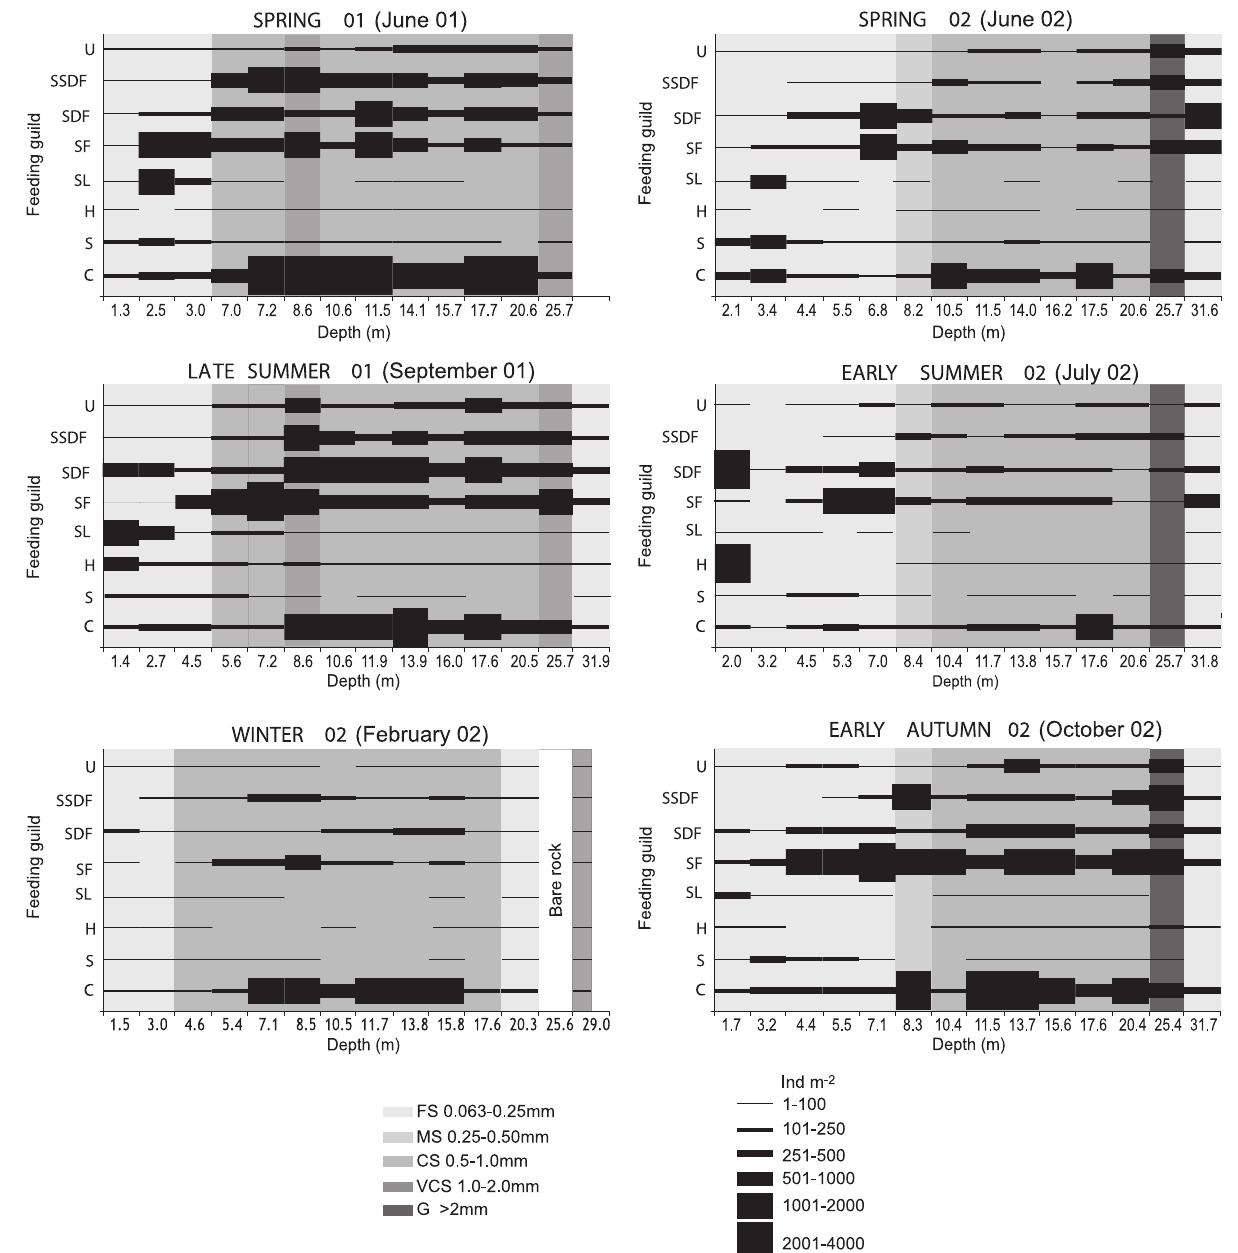
Fig. 4 . – Density of the different trophic guild groups along the depth gradient, for the different seasons; grain size variations are indicated. Feeding guilds : C, carnivores; h, herbivores; s, scavengers; sDF, surface-deposit feeders; sF, suspension feeders; sl, sand-lickers; ssDF, subsurface-deposit feeders;; u, unknown; Grain Size : Fs, fine sand; Ms, medium sand; Cs, coarse sand; VCs, very coarse sand; g,